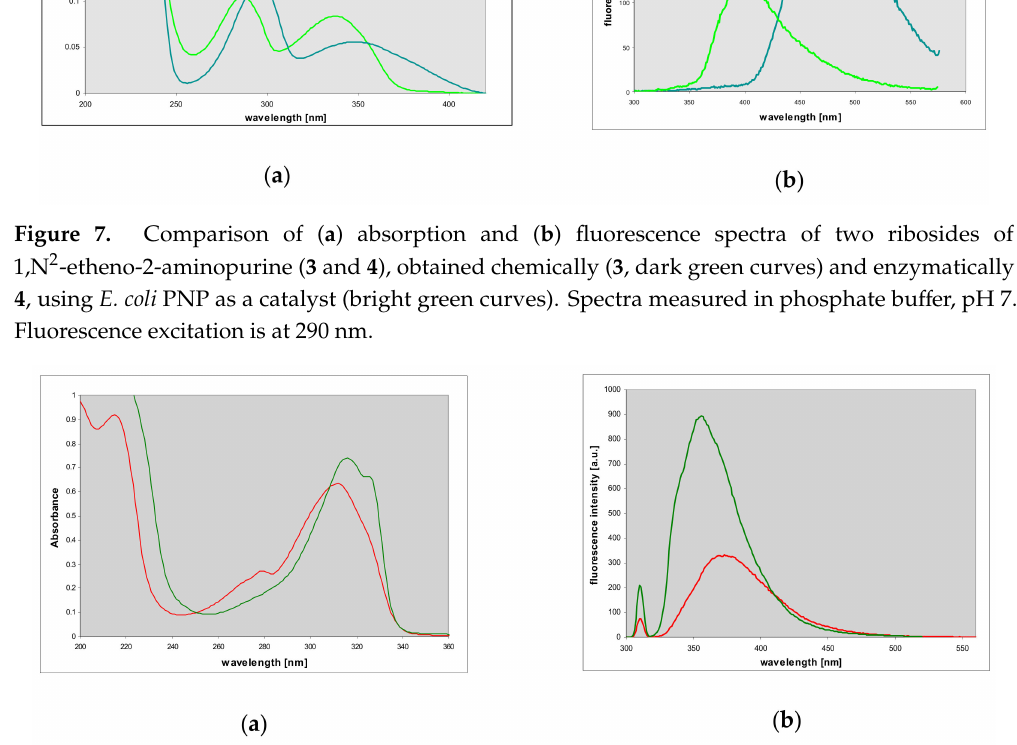
Figure 8. Electronic absorption ( a ) and fluorescence ( b ) spectra of the N 2 ,3-etheno-2- aminopurine-N 2 - β - d -riboside ( 5 ) in aqueous media. Green lines: pH 7, red lines: pH 3. Fluorescence excitation was 310